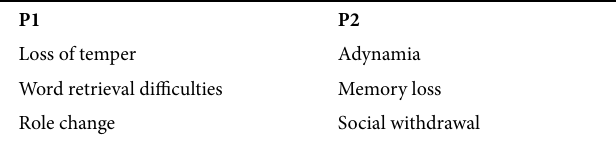
Table III. Summary of the themes identified from the participants’ perspectives of communication after MTBI P1